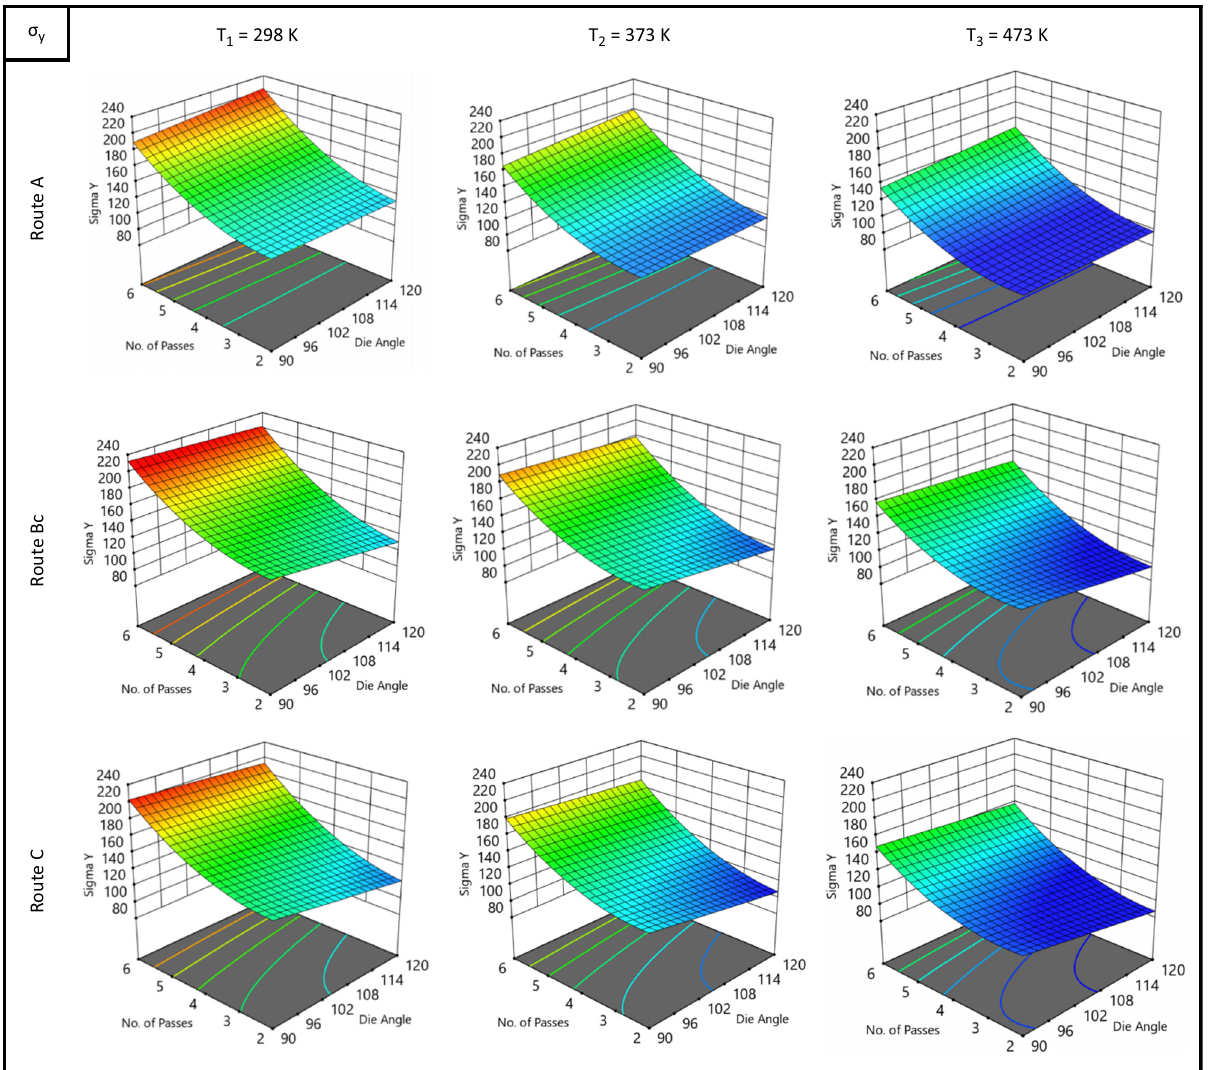
Figure 14: Response surface plot of σ y as a function of die angle, number of passes, route type, and processing